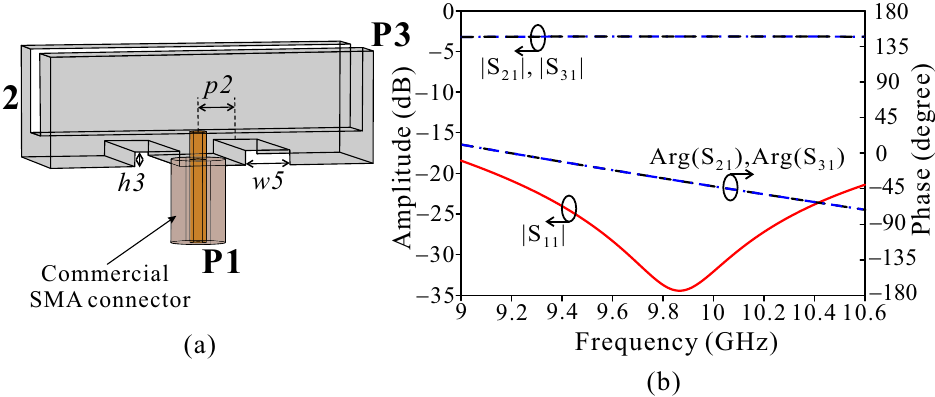
Figure 8. Design of the feeding structure for the VP linear array. ( a ) T-junction power divider. ( b ) S-parameters of the power divider. ( c ) Coaxial-to-RWG transition. ( d ) S-parameters of the transition. (Design parameters: w 1 = 2.35, w 2 = 3.6, w 3 = 1, w 4 = 7.8, l 1 = 6.55, l 2 = 4.4, h 1 = 1.15, h 2 = 1, and p 1 = 2.9 (units: mm)).